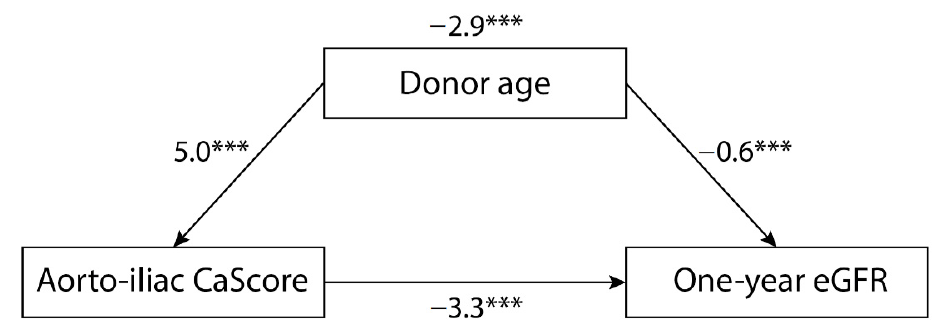
Figure 1. Graphical illustration of the magnitude of confounding for one-year estimated glomerular filtration rate (eGFR), showing the regression coefficients for the associations (*** indicating a p -value < 0.0001). The direct effect of the aorto-iliac CaScore on one-year eGFR was − 3.3 (95%CI − 5.1 to − 1.5) and the effect on the confounder (donor age) was 5.0 (95%CI 3.8 to 6.2). The direct effect of the confounder on one-year eGFR was − 0.6 (95%CI − 0.7 to − 0.5), with a bootstrapped indirect effect of − 2.9 (95% CI − 4.0 to −